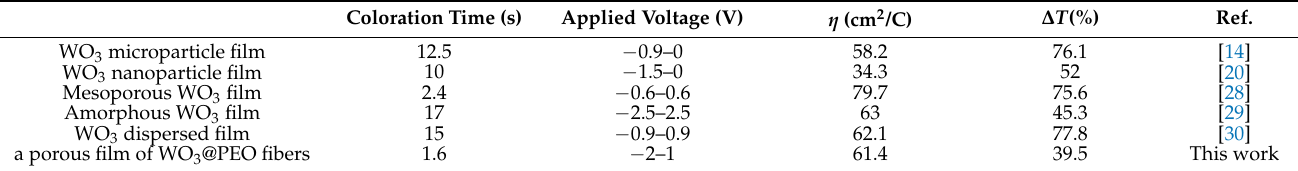
Table 3. Comparison of electrochromic characteristics of previously reported WO 3 -based ECDs with an ECD fabricated in the present study.